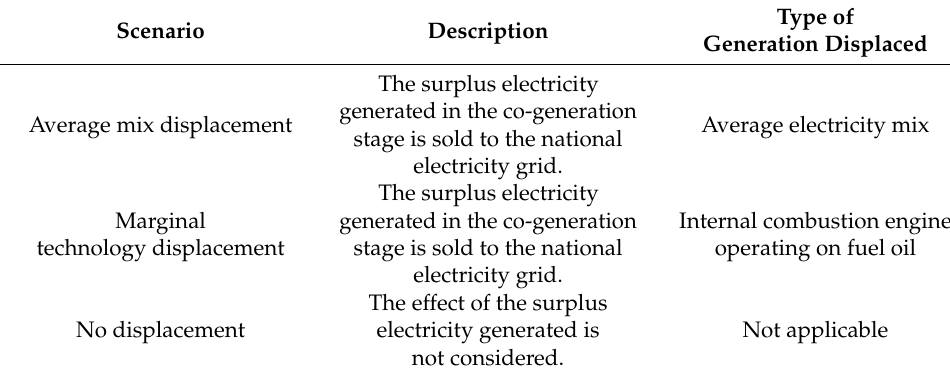
Type of Generation Displaced